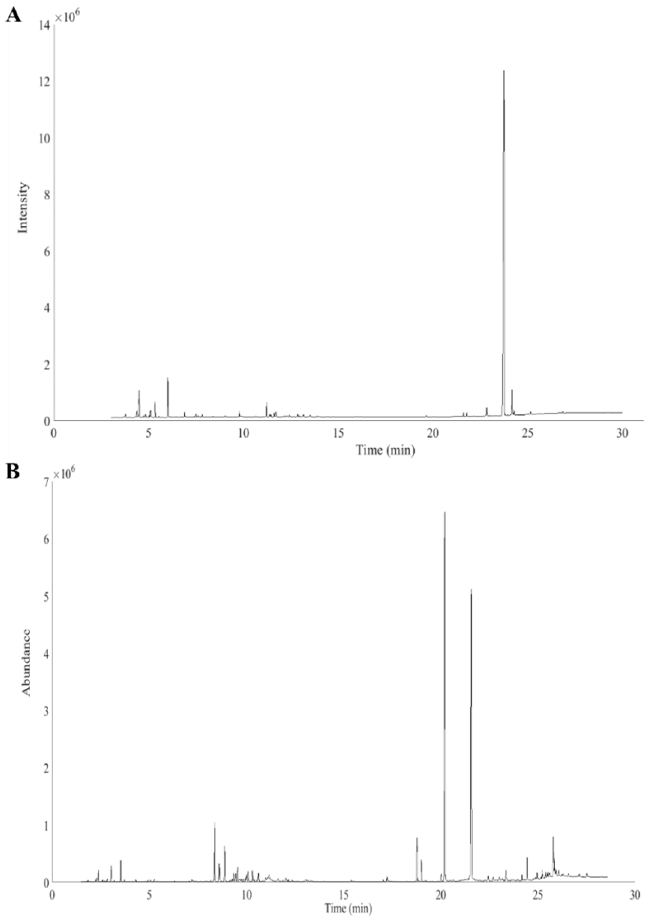
Figure 1. Cannabis fingerprints derived from ( A ) GC–FID and ( B ) GC–MS (without THC peak).